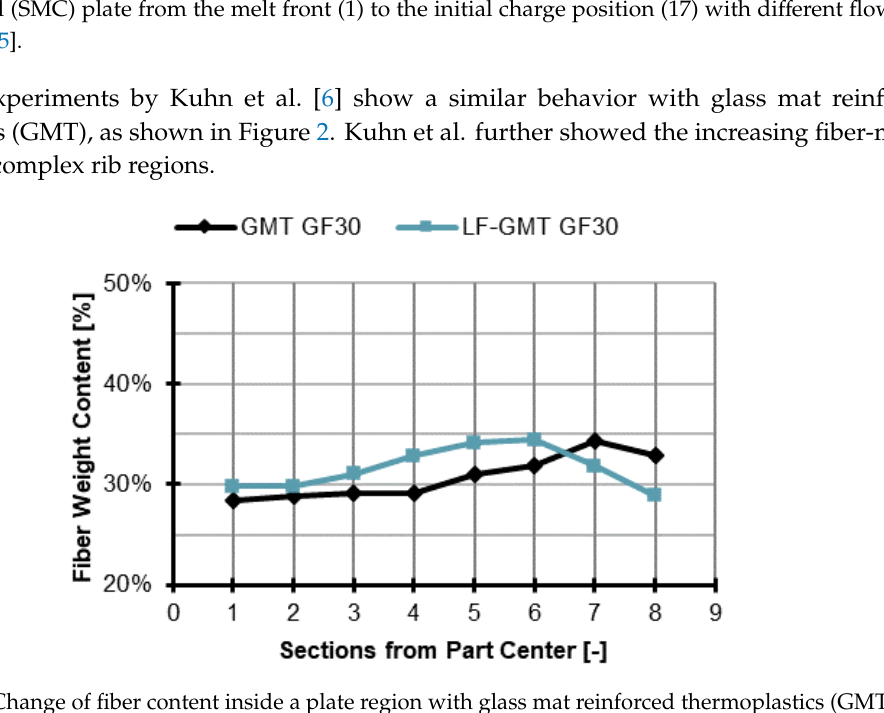
Figure 2. Change of fiber content inside a plate region with glass mat reinforced thermoplastics (GMT) GF30 and long fiber GMT GF30 .